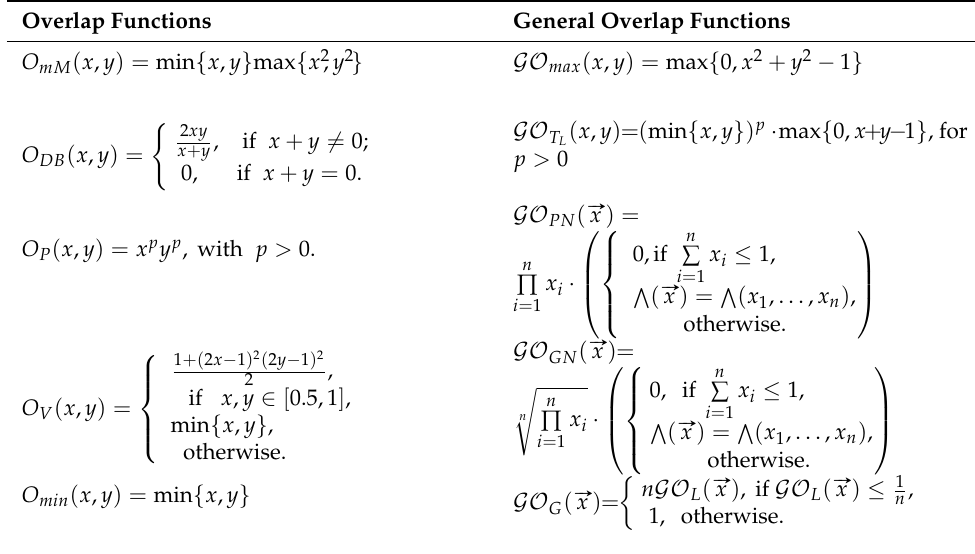
Table 1. Examples of overlap functions O and general overlap functions GO